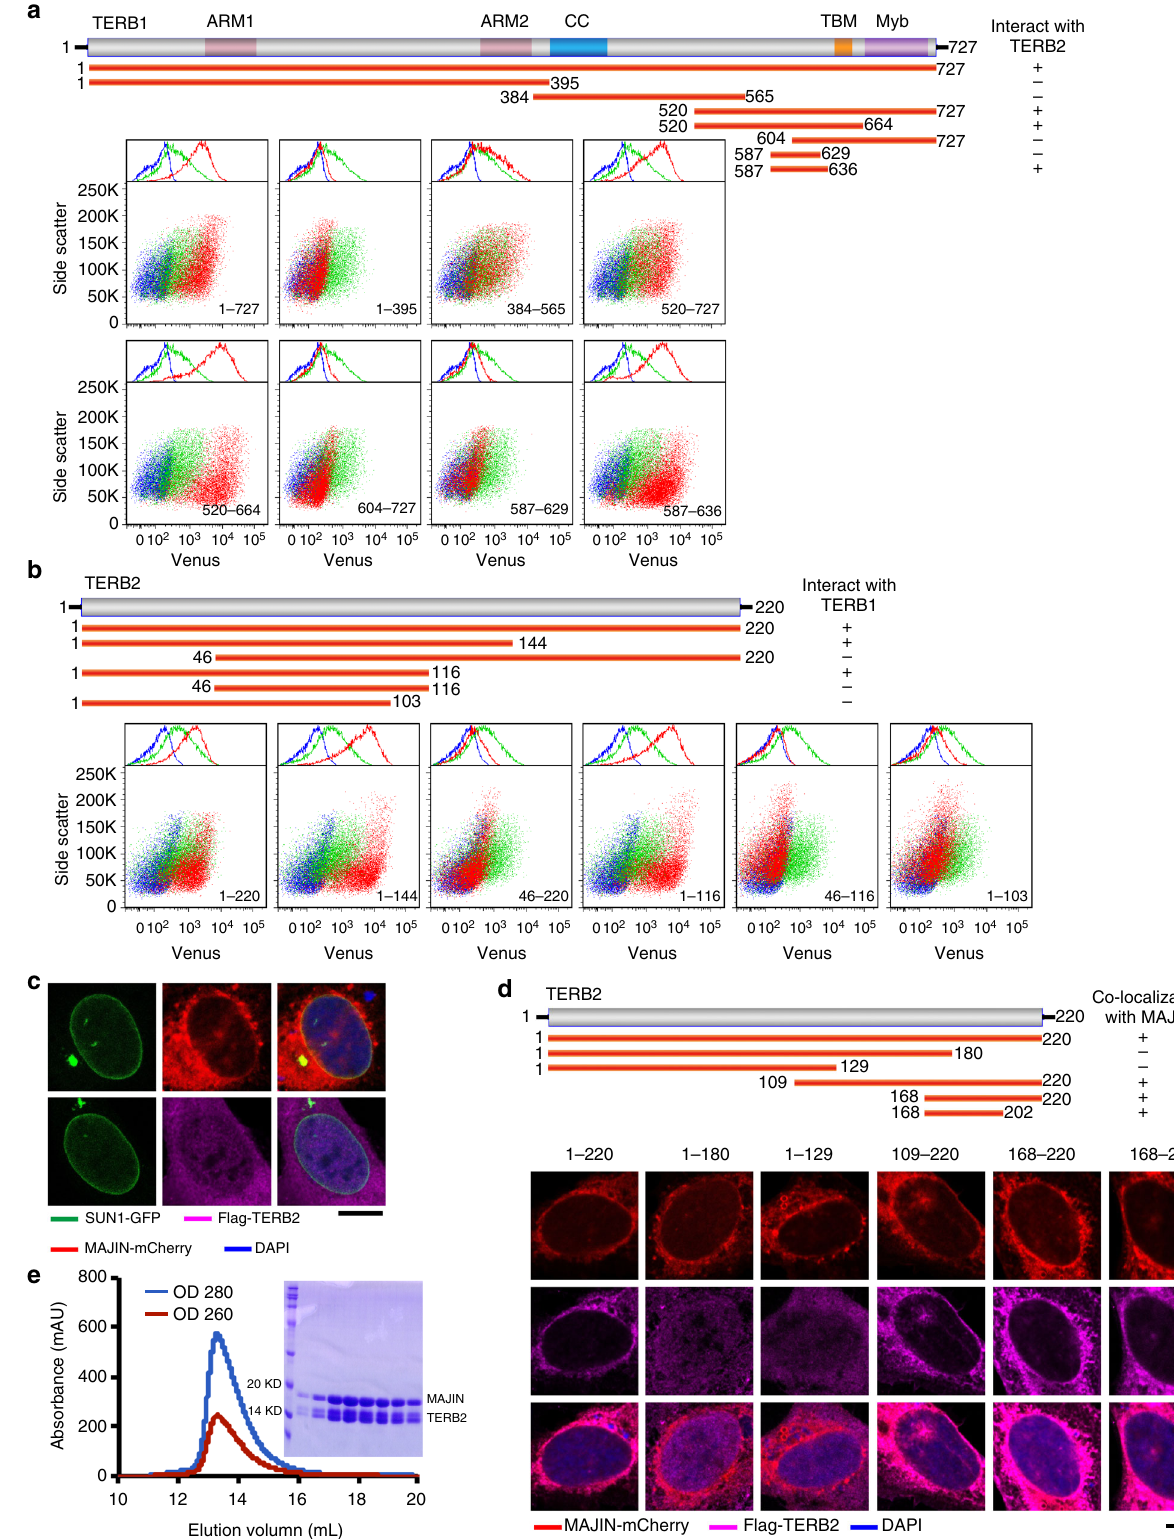
+ ion, playing a key role in de fi ning the overall shape of TERB1 T2BM (Fig. 2c). TERB1 T2BM adopts an extended conforma- tion and packs against the concaved surface of TERB2 NTD , burying ~1400 Å 2 of surface area at the interface (Fig. 2d).